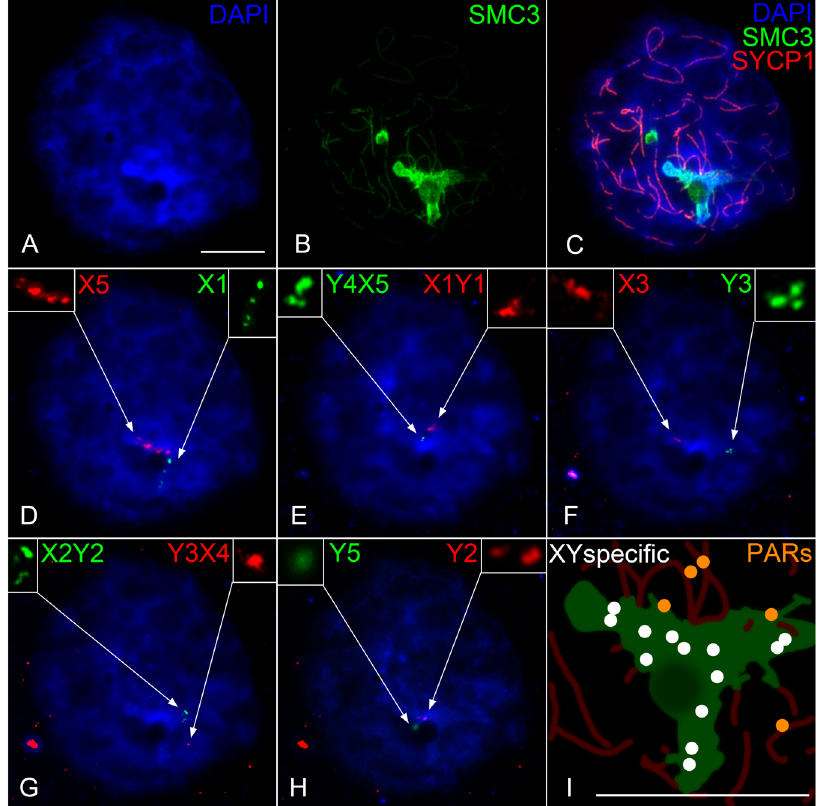
Figure 8. Sequential sex chromosome specific immuno-FISH on a platypus “stage g” pachytene cell. Nuclei were stained with SYCP1 (red), SMC3 (green) and DAPI (blue) ( A – C ). Sequential FISH were carried out in five subsequent experiments in the order D – H where enlarged views of the FISH signal are shown in the top corners of each panel ( D – H ). A schematic of an enlarged view of region containing sex chromosomes indicates the location of XY specific probes (white) and PARs (orange) ( I ). Scale bars = 10 µ